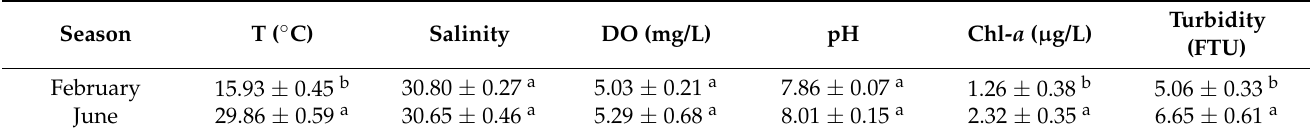
Table 2. Environmental conditions at different sampling seasons.